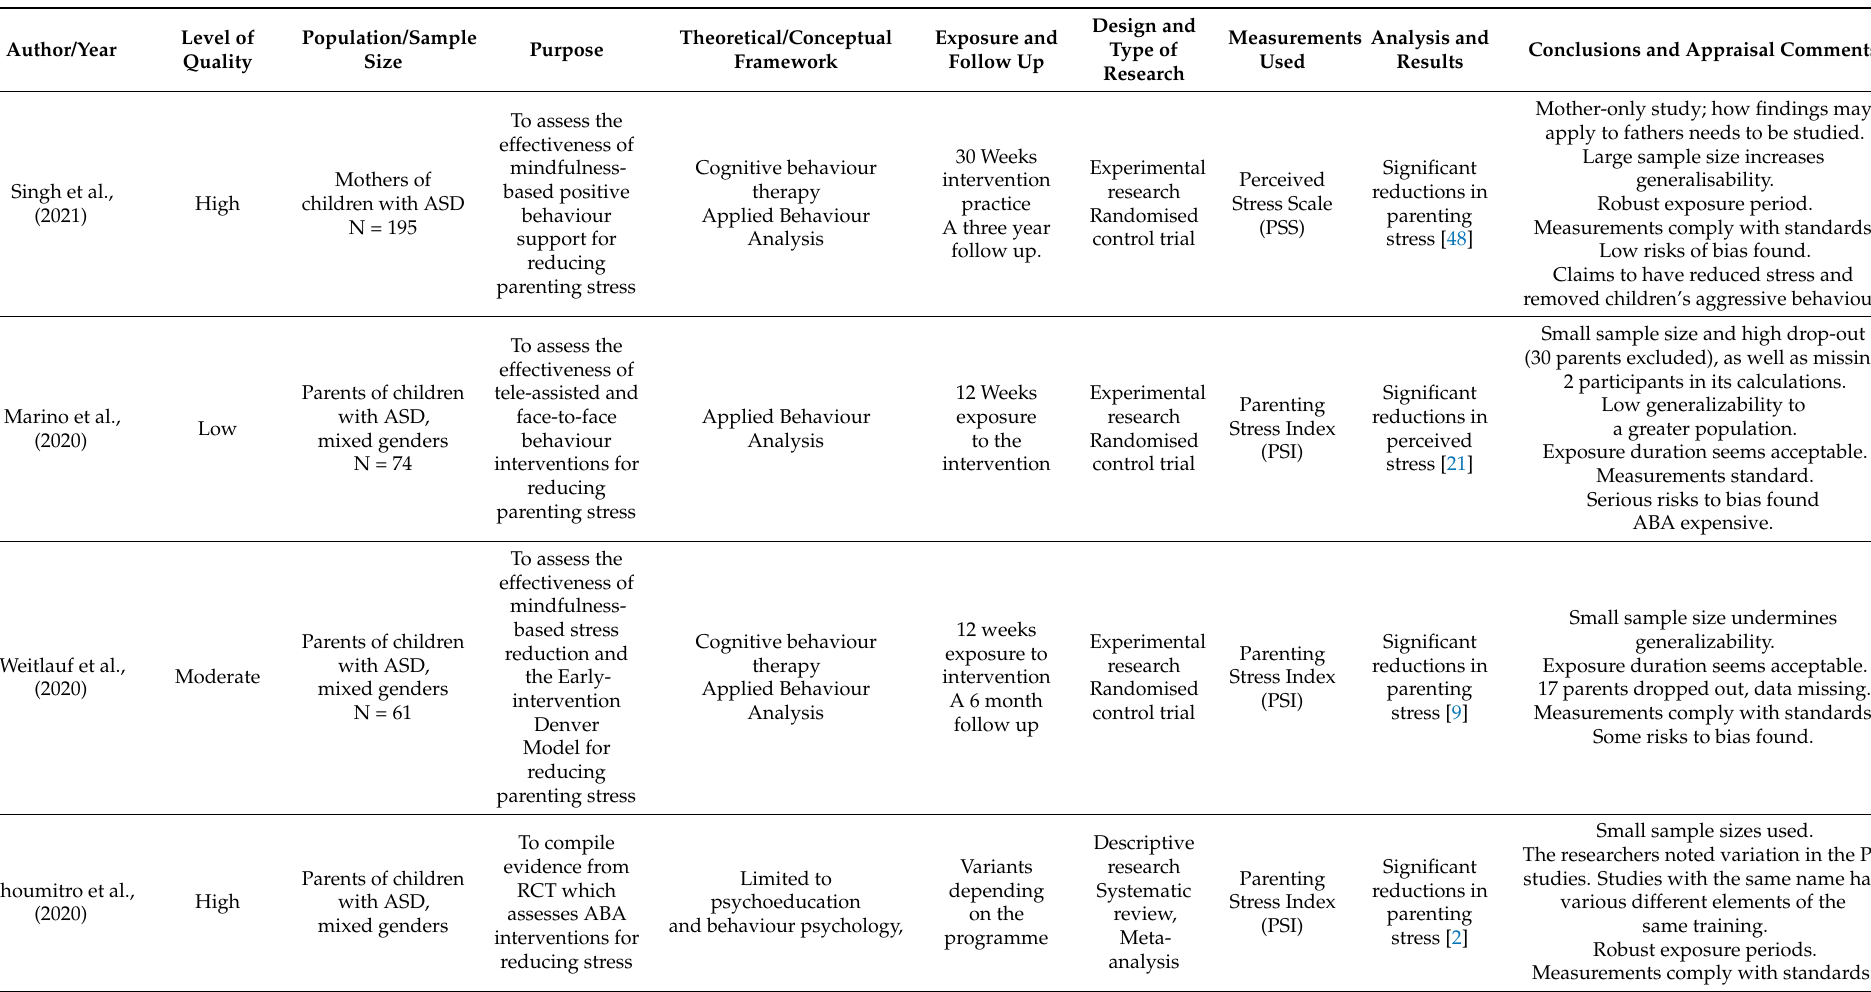
Table 2. Literature review